Question: Describe this figure in one sentence.
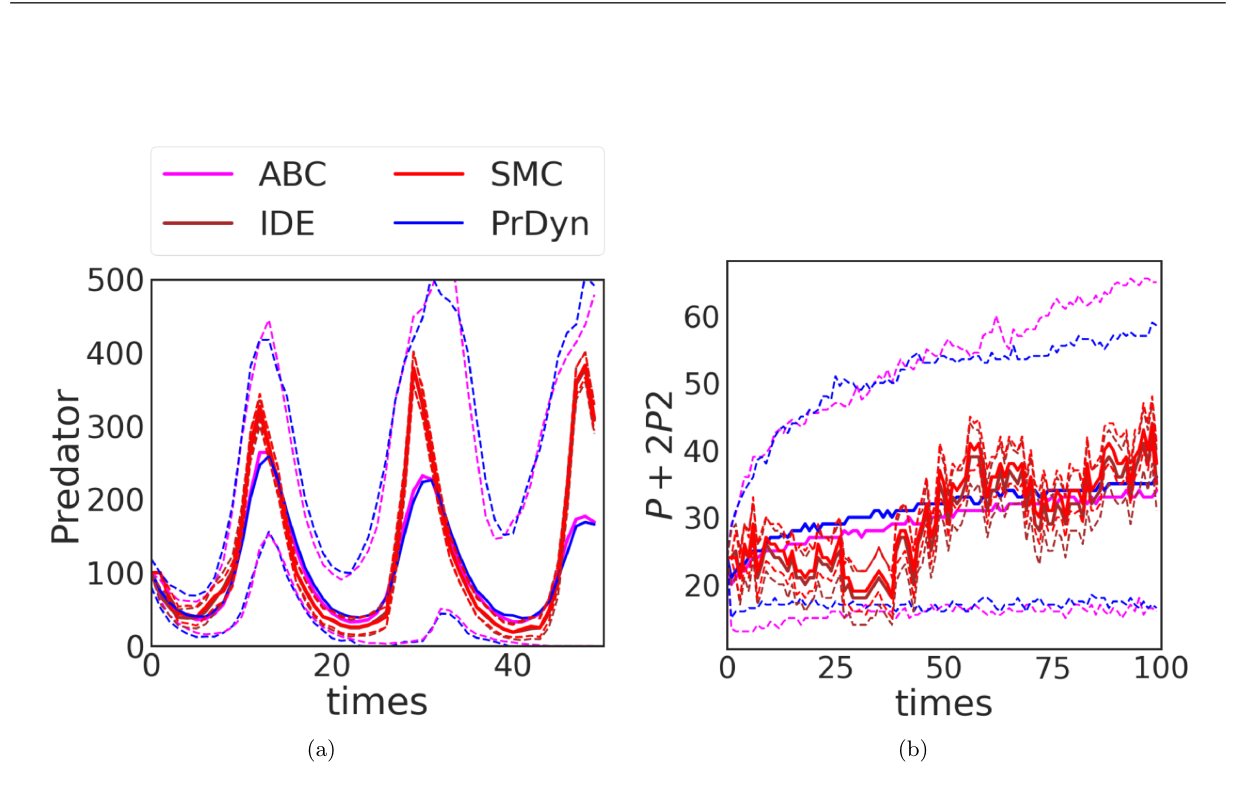
Answer: Posterior distributions of one component of the latent sample path (the hidden states) x summarised by the mean (solid lines) and 95% credible intervals (broken lines), for the Lotka-Volterra (a), Prokaryotic autoregulator (b) model. Here SMC, IDE and PrDyn estimates of x corresponds to an SNLE estimate of θ.